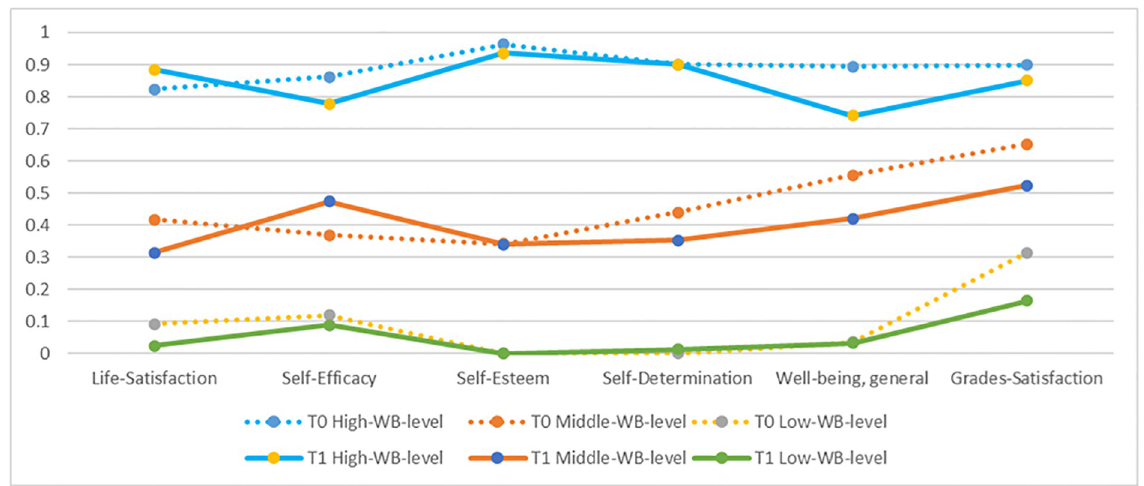
Fig 2. Pattern plot for both waves with class-specific probabilities of the respective high level for the indicators.